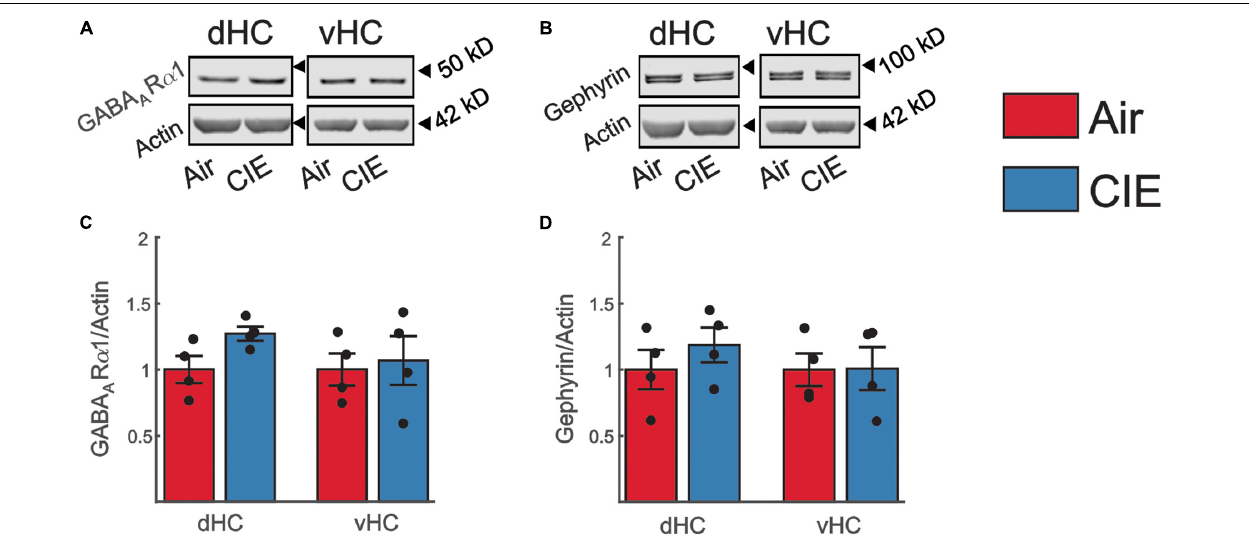
FIGURE 8 | Expression levels of proteins commonly associate with changes in inhibitory neurotransmission are not impacted by CIE-treatment in the dHC or vHC. Representative western blot examples illustrating the expression of (A) the GABA A R α 1 subunit or (B) Gephyrin. The corresponding expression of actin (normalization protein) is shown in the lower blot panel of each protein of interest. (C,D) Group data, normalized to actin and the internal control group (Air), for (C) the GABA A R α 1 subunit (Air n = 4, CIE n = 4) and for (D) Gephyrin (Air n = 4, CIE n = 4) illustrating no change in the expression of these proteins in the dHC and vHC following CIE-treatment. All data are expressed as the mean ±